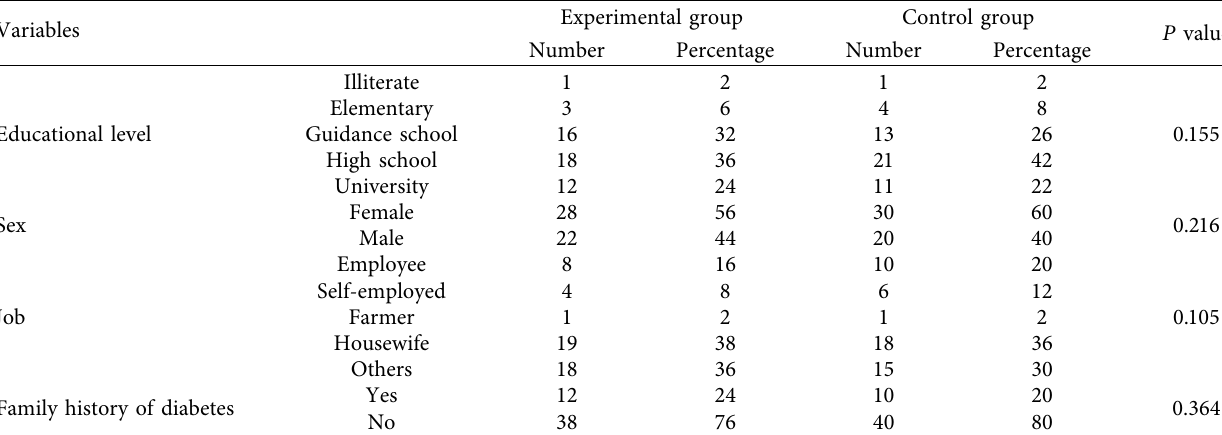
Table 1: Demographic information of studied